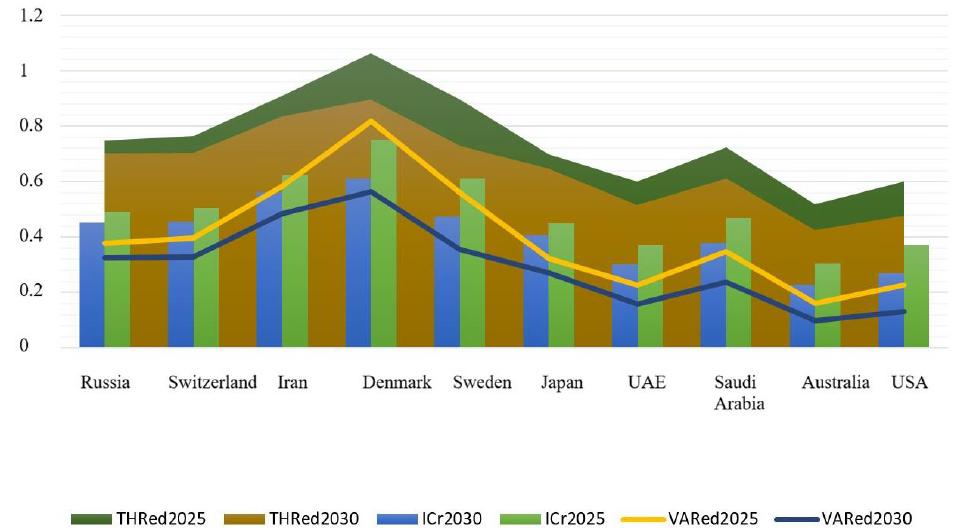
Figure 6. Energy dependence forecasts up to 2025 and 2030 for the least energy-dependent countries. Source: developed by the authors .